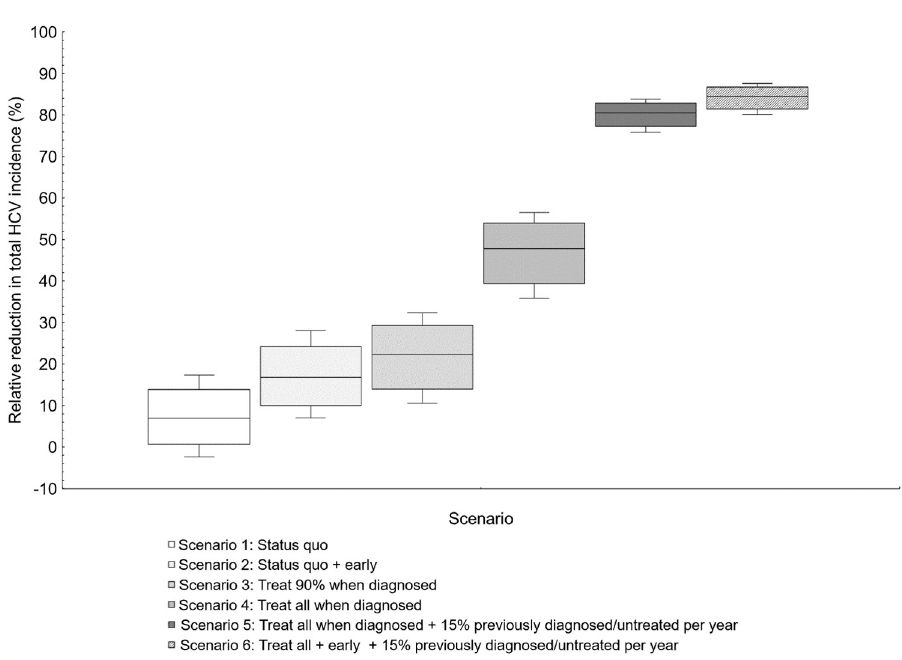
Fig 3. Relative reduction in total hepatitis C virus (HCV) incidence between 2015–2030 among men who have sex with men living with diagnosed human immunodeficiency virus (HIV) in Germany.